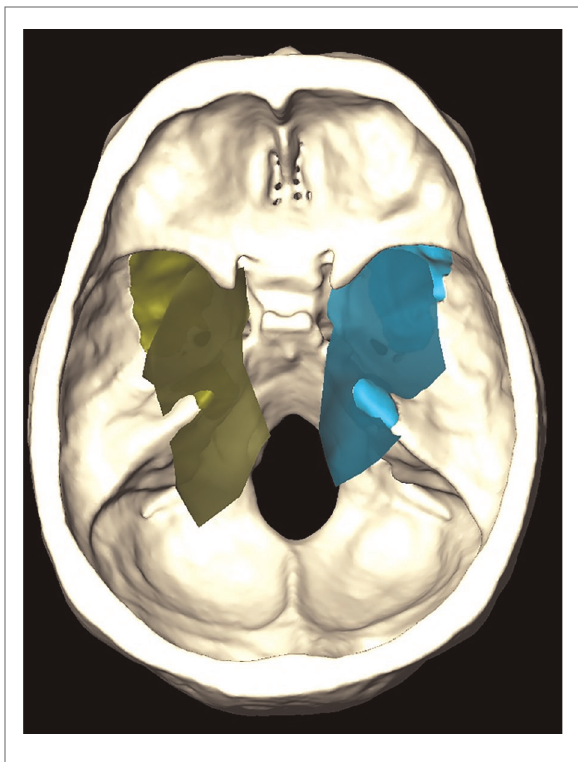
FIGURE 8 Amira software 3D reconstruction showing the working area (superimposed shaded green and blue areas) at the level of the middle and posterior cranial fossae, which can be obtained after bone removal (darker underimposed green and blue